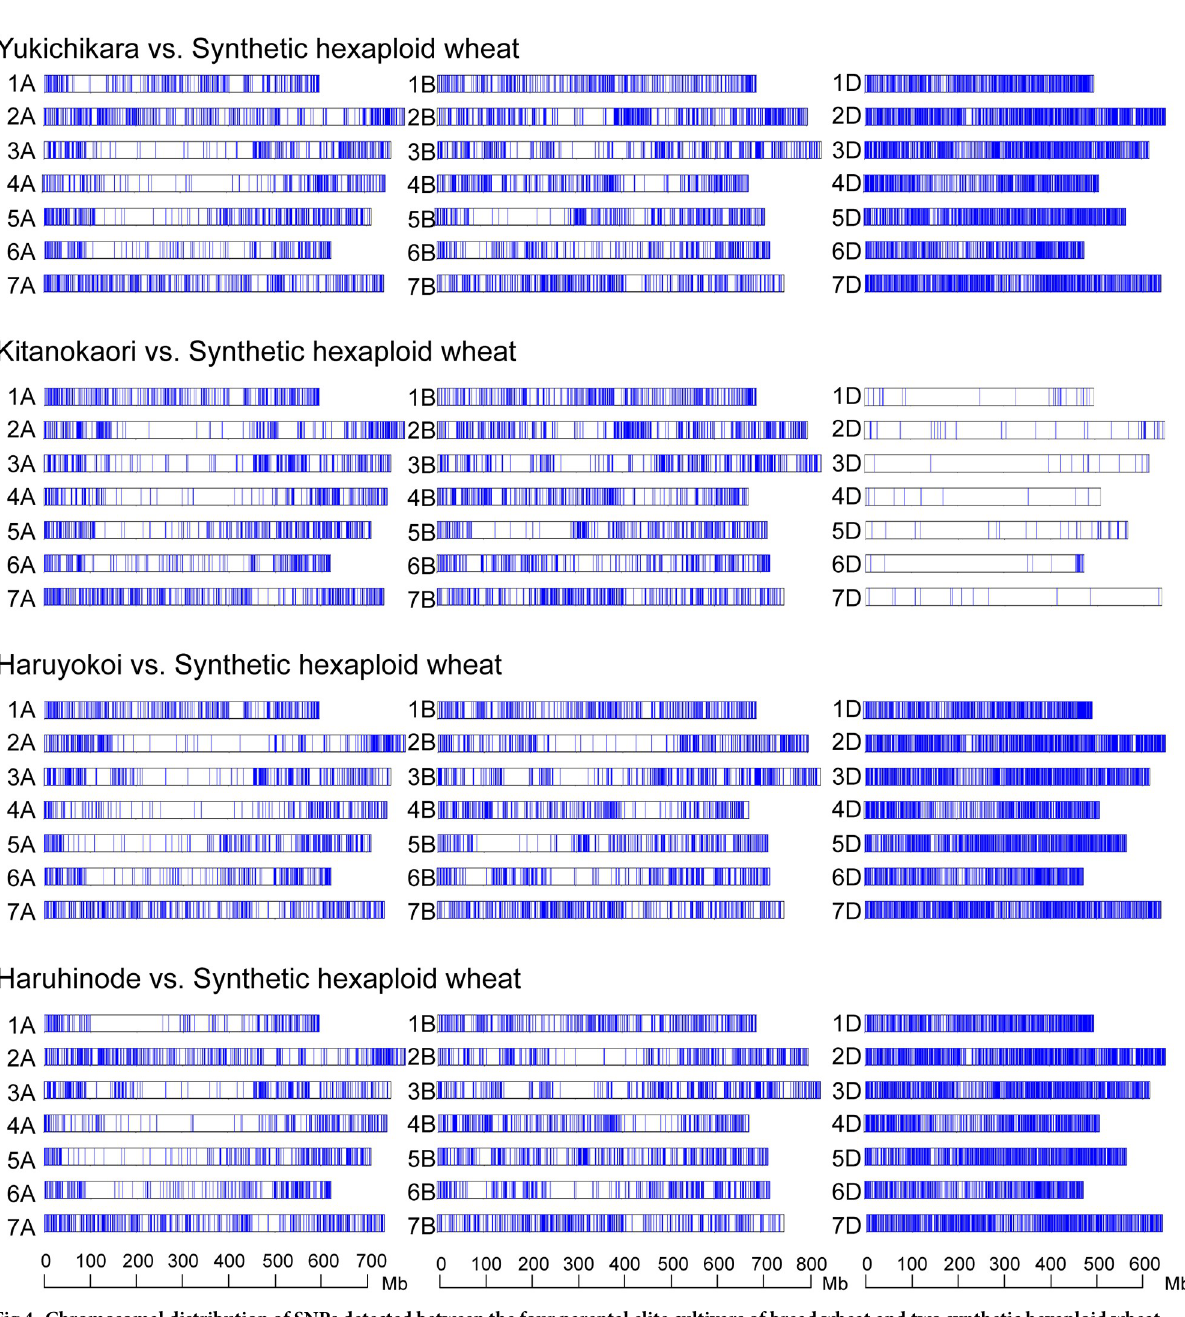
Fig 4. Chromosomal distribution of SNPs detected between the four parental elite cultivars of bread wheat and two synthetic hexaploid wheat lines. RNA-seq data of the synthetic hexaploid wheat was generated by combining RNA-seq data of Ldn and of Ae . tauschii accessions AT74 or PI476874. The scant SNPs on the D chromosomes in the pair between Kitanokaori vs. the synthetic hexaploid wheat (Ldn/PI476874) were caused by the low coverage data of Ae . tauschii PI476874 generated by the Roche 454 sequencing